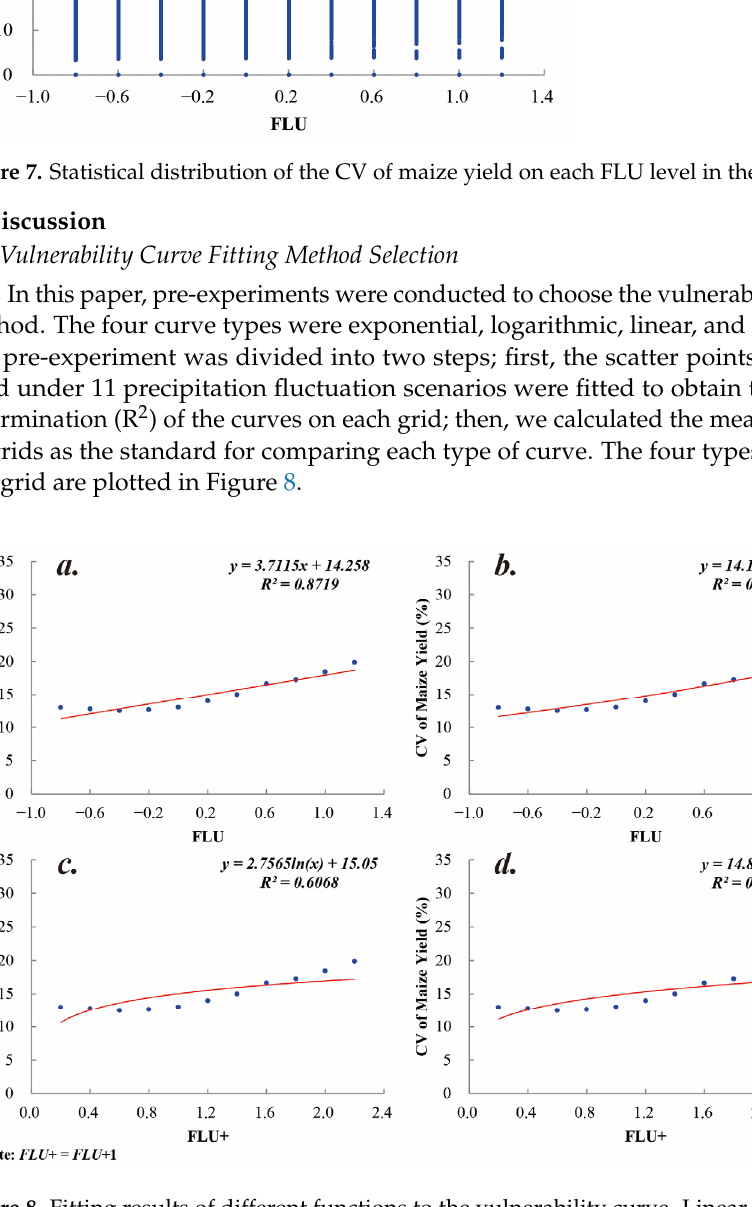
Figure 8. Fitting results of different functions to the vulnerability curve. Linear function ( a ); expo- nential function ( b ); logarithmic function ( c ); power function ( d ). Because of the value range of the independent variable, the independent variable is ‘FLU + ’ (equal to ‘FLU + 1 ′ ) in ( c ) and ( d ). The mean values of R 2 of the four types of curves were calculated as Table